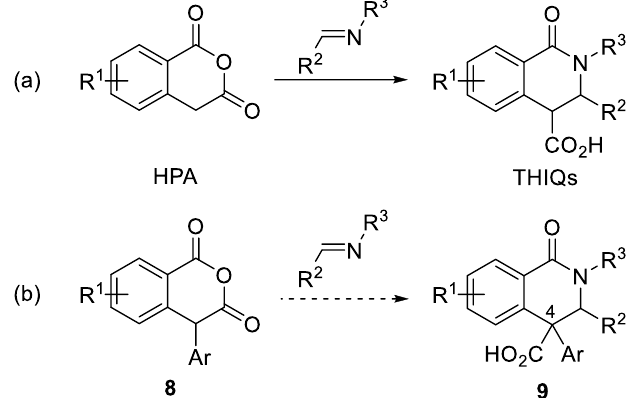
Figure 3. ( a ) Traditional CCR of HPA. ( b ) Synthetic goal pursued in this work.